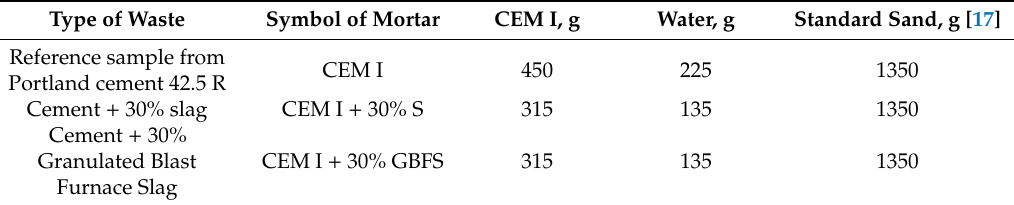
Table 3. Composition mix of mortars, expressed in gram.